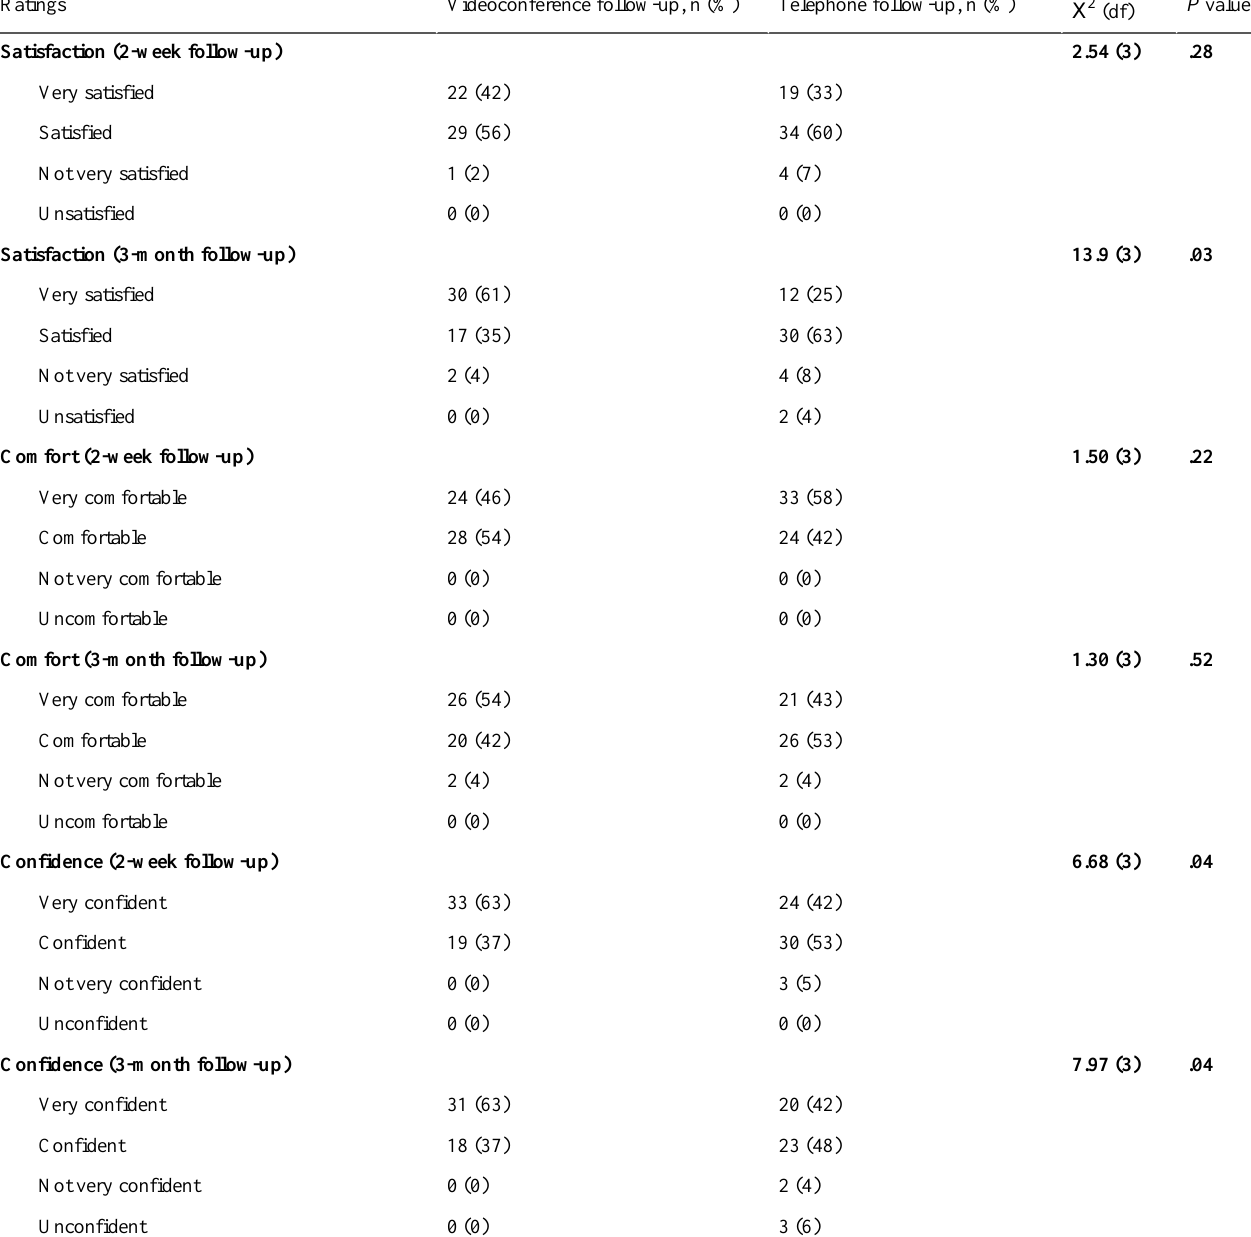
Table 7. Ratings of satisfaction, comfort, and confidence at 2-week and 3-month follow-up